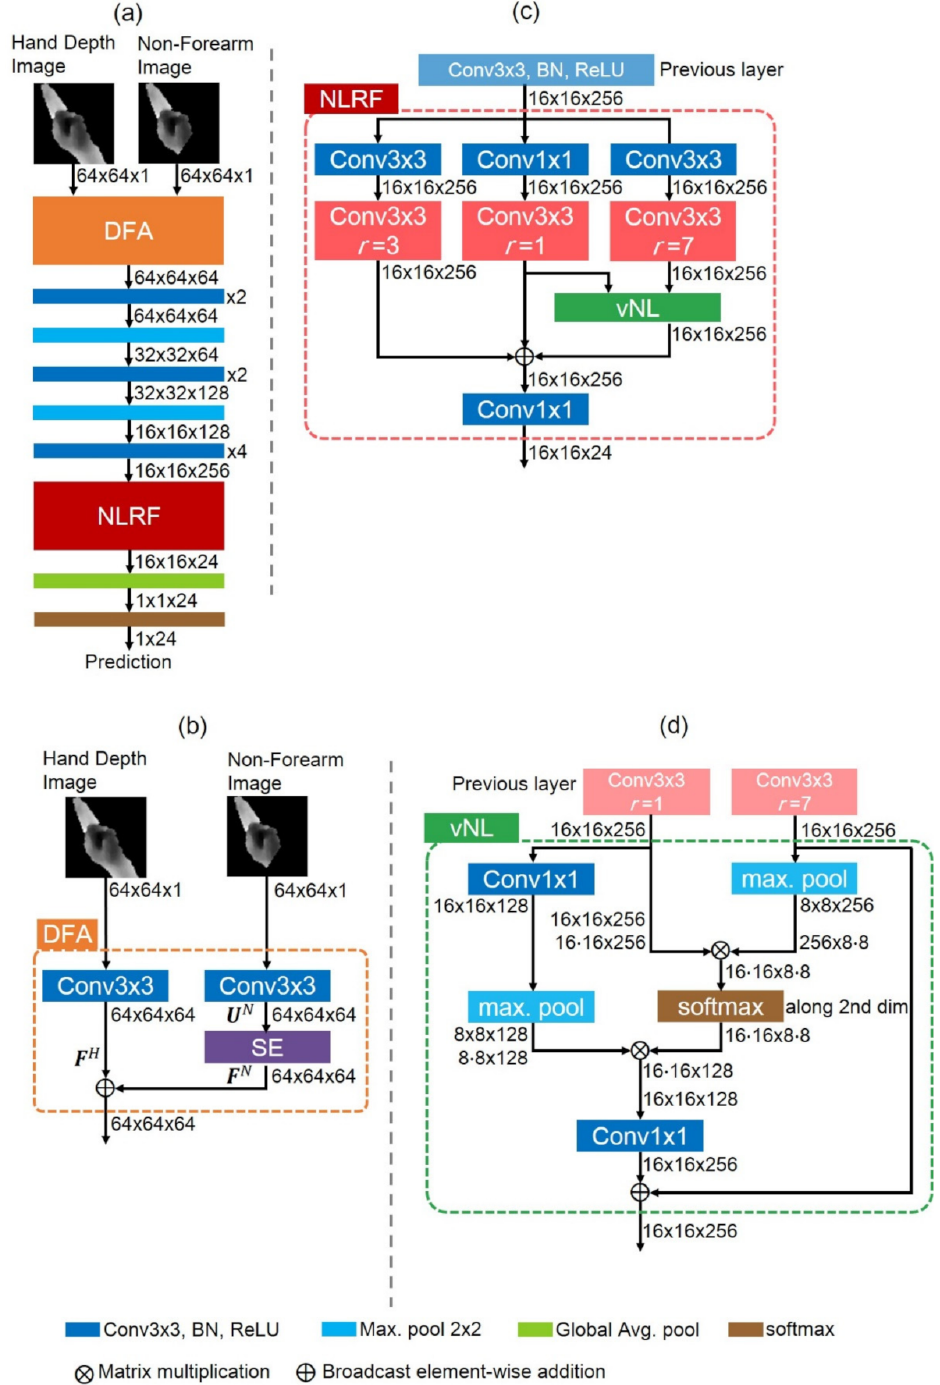
Figure 3. Overview of our hand gesture recognition model. ( a ) RFaNet. ( b ) DFA block. ( c ) NLRF block. ( d ) Variant of non-local block (vNL). SE: squeeze-and-excitation block; non-forearm image: hand depth image after forearm removal process; r : atrous sampling rate which corresponds to the stride when sampling the input